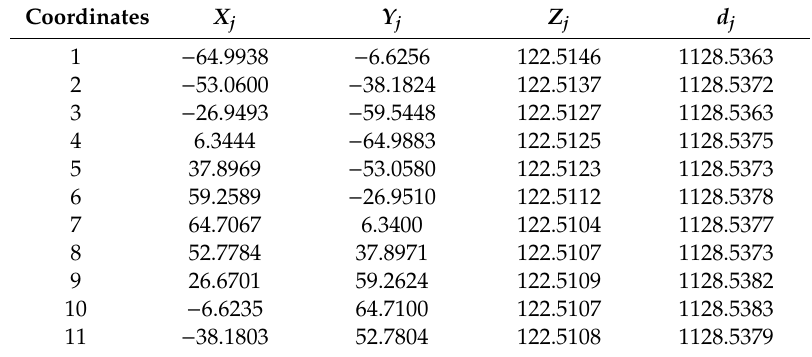
Table 1. Coordinates of laser tracer stations and their distance to the initial measured point (unit: mm).